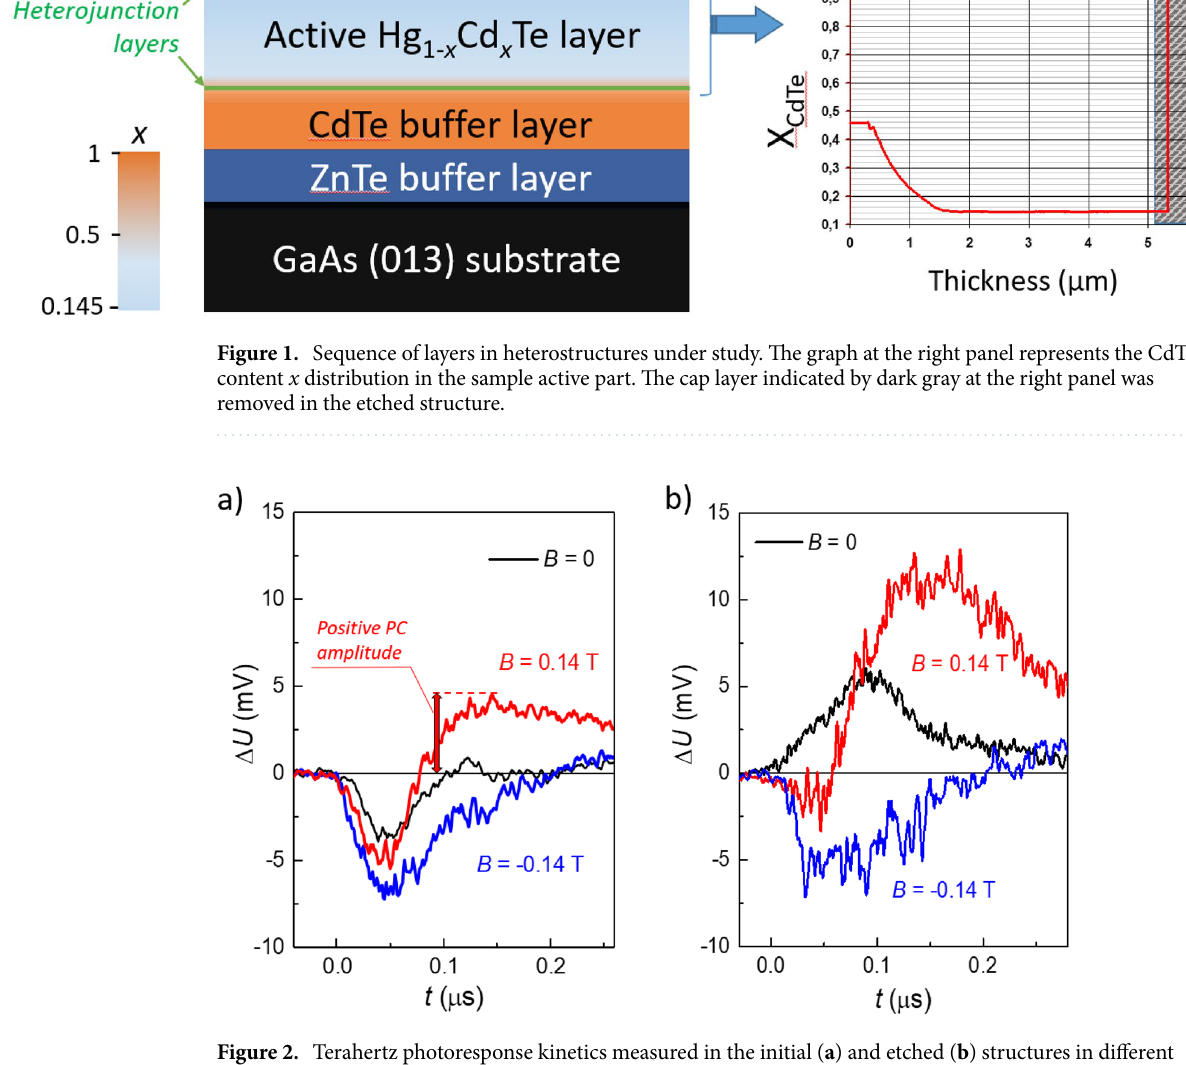
Figure 2. Terahertz photoresponse kinetics measured in the initial ( a ) and etched ( b ) structures in different magnetic fields. For the clarity, the positive ∆U values in the figure correspond to the positive photoconductivity, the negative ∆U —to the negative photoconductive response. B = 0 (black curves), B = 0.14 T (red curves), B = − 0.14 T (blue curves). The terahertz radiation frequency f = 1.07